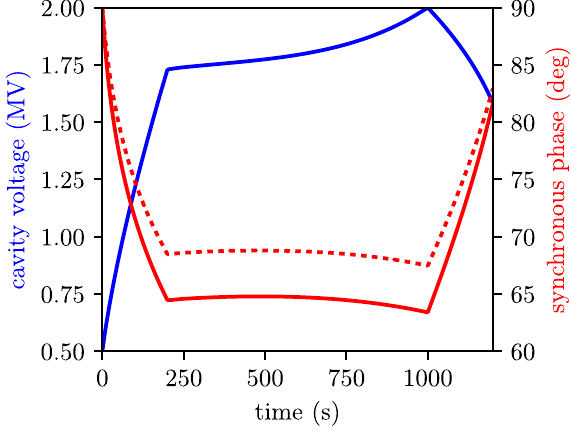
9. Instantaneous generator power with the direct rf feed- back for calculations shown in Fig.